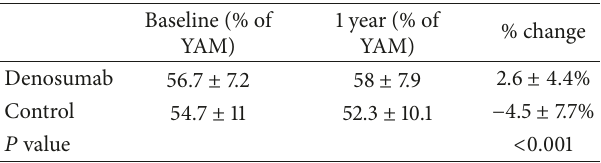
Table 6: BMD at the distal third of